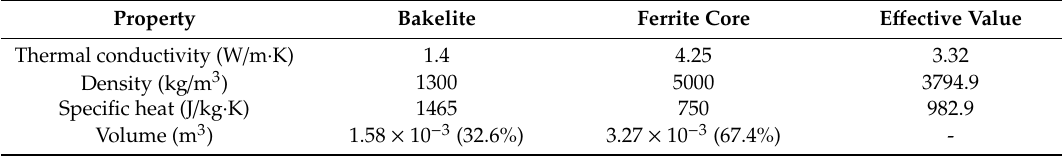
Table 1. Material properties of L-dummy used in the thermal